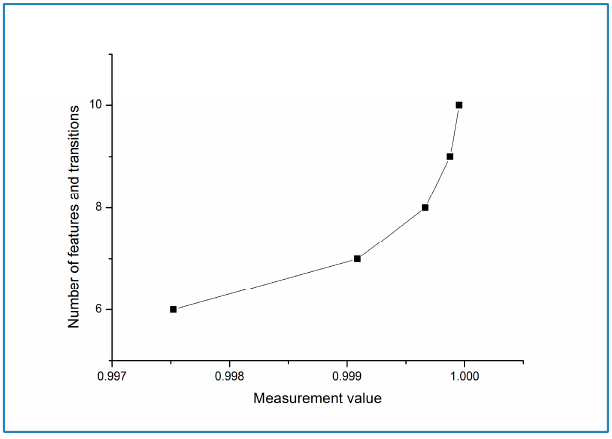
Figure 6. Relationship between the number of features and transition and the measurement results. From the measurement results for 22 objects in Benchmarks, the following two conclusions are